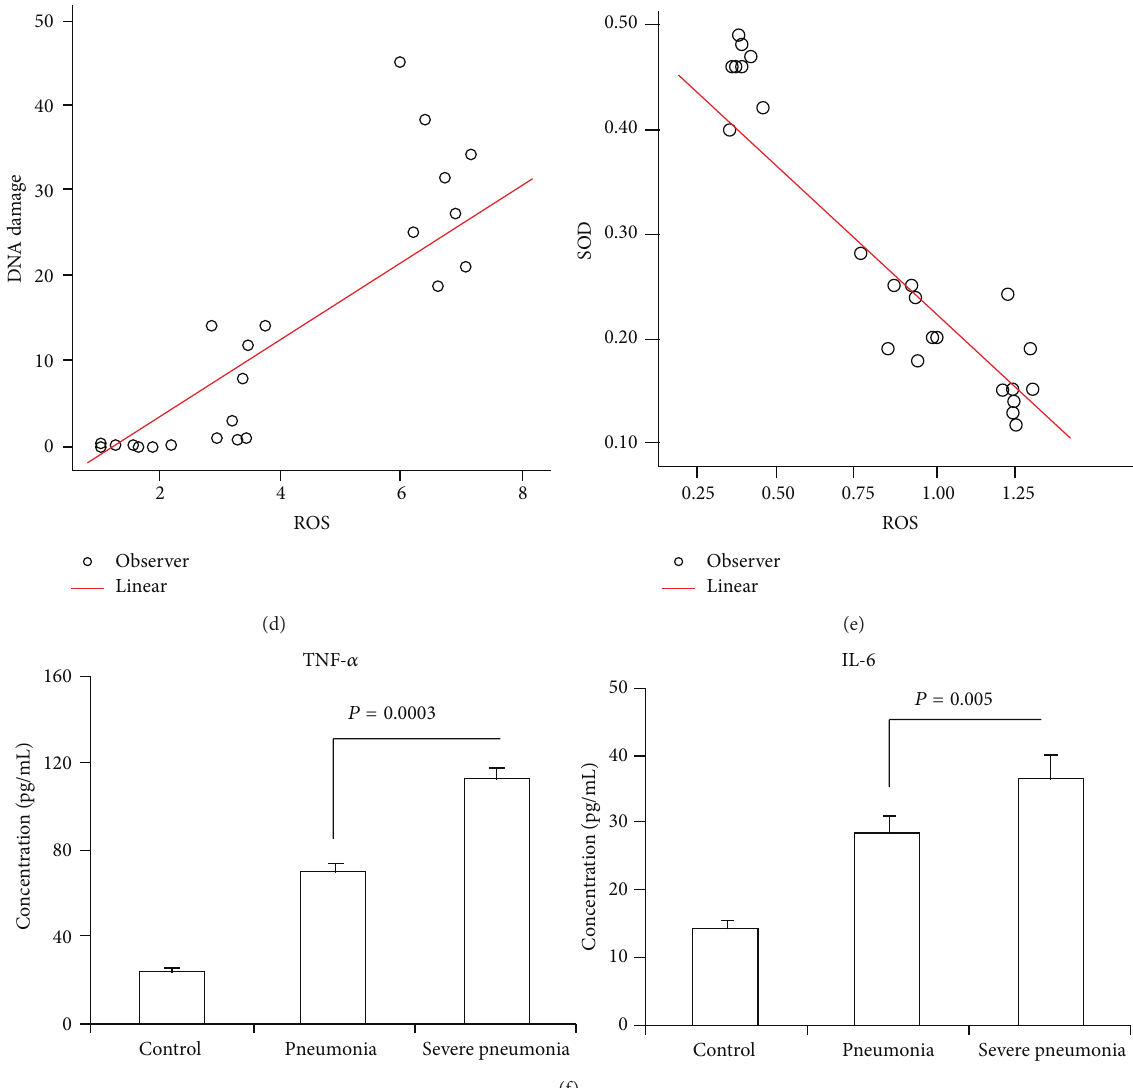
Figure 2: Oxidative stress, DNA damage, TNF- 𝛼 , and IL-6 in severe CAP . (a) Intracellular ROS were detected by confocal microscope using DHE probe. ROS level was represented by fluorescence intensity ( × 400). (b) DNA damage was detected by comet assay using confocal microscope ( × 400). DNA damage score was analyzed with comet assay IV software. (c) SOD activity in serum was measured using the SOD assay kit WST. (d) Correlations between ROS and DNA damage were also evaluated. (e) Correlations between ROS and SOD were also evaluated. Spearman’s correlation with a two-tailed test was used for statistical analyses. (f) Standard ELISA was performed to determine the levels of TNF- 𝛼 and